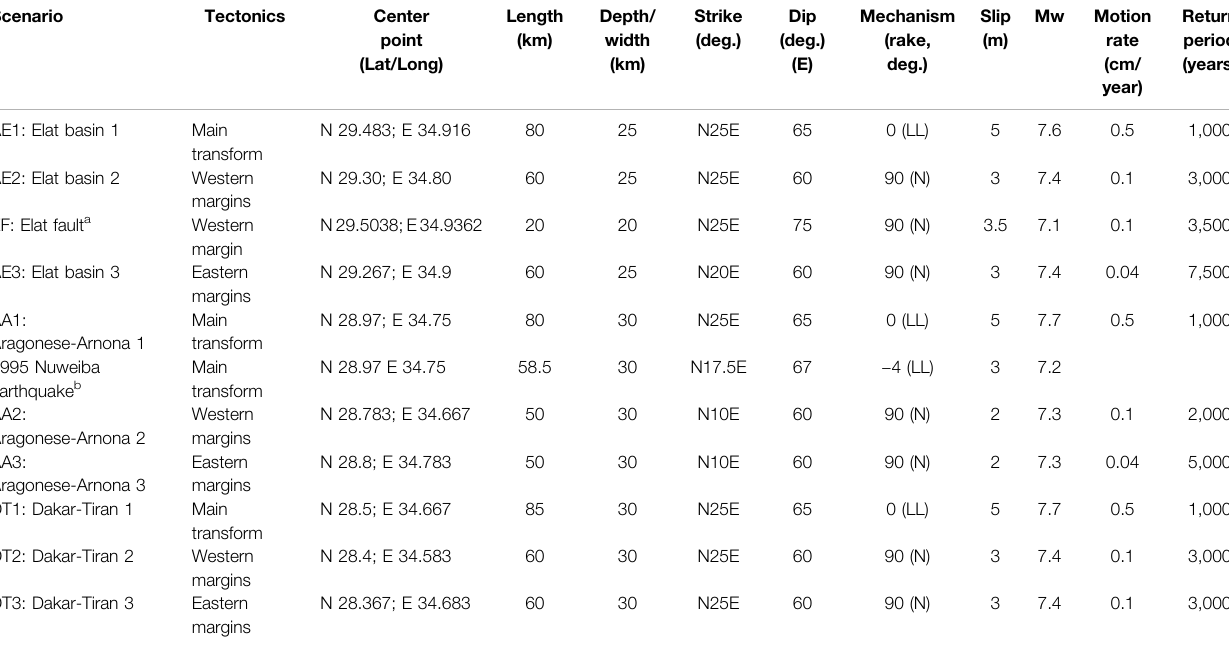
TABLE 1 | Inventory of potential worst-case Gulf of Elat – Aqaba (GEA) earthquake scenarios used for our tsunami simulation. See Earthquakes for detailed explanation regarding the origin and rationale of the source parameters. Scenario Tectonics Center